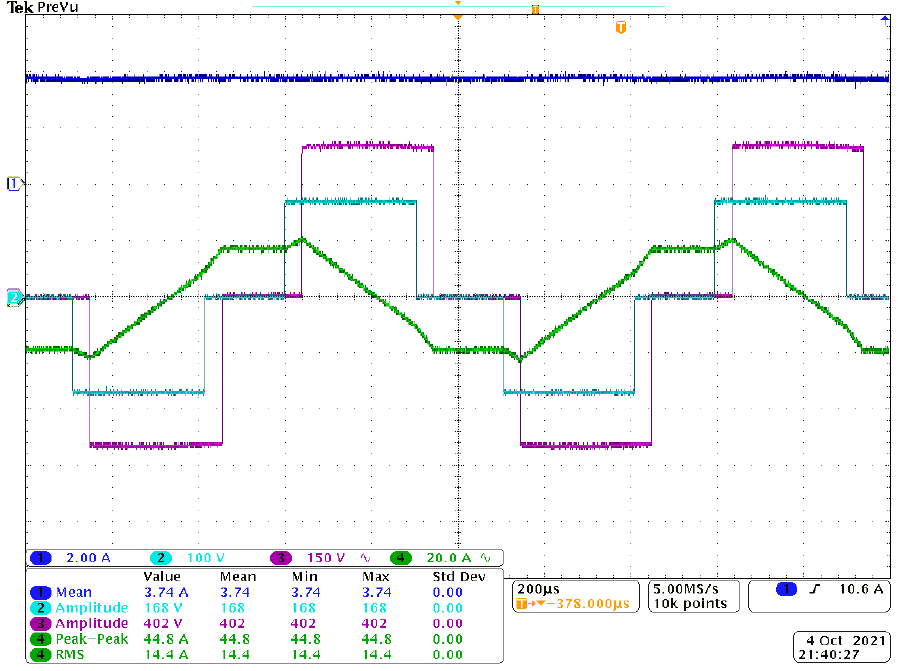
Figure 16. DAB operation at medium power under the DPS method.